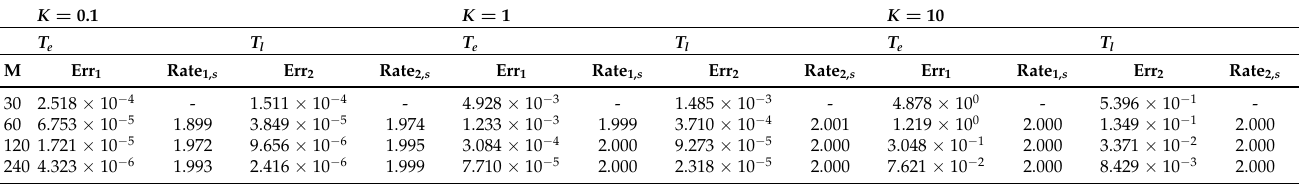
Table 5. Spatial convergence rate when N = 1000 and ( α , β ) = ( 0.7,0.3 ) for Example 1.